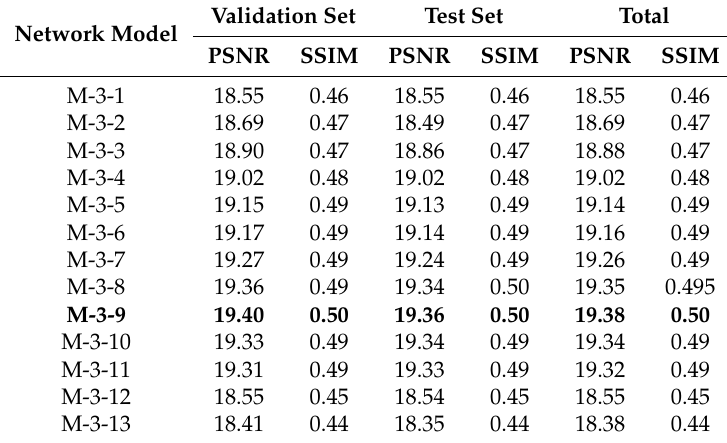
Table 5. Performance according to depth of decoder in the proposed asymmetric structured networks. Bold-faced numbers indicate the top-ranked network model and its scores.